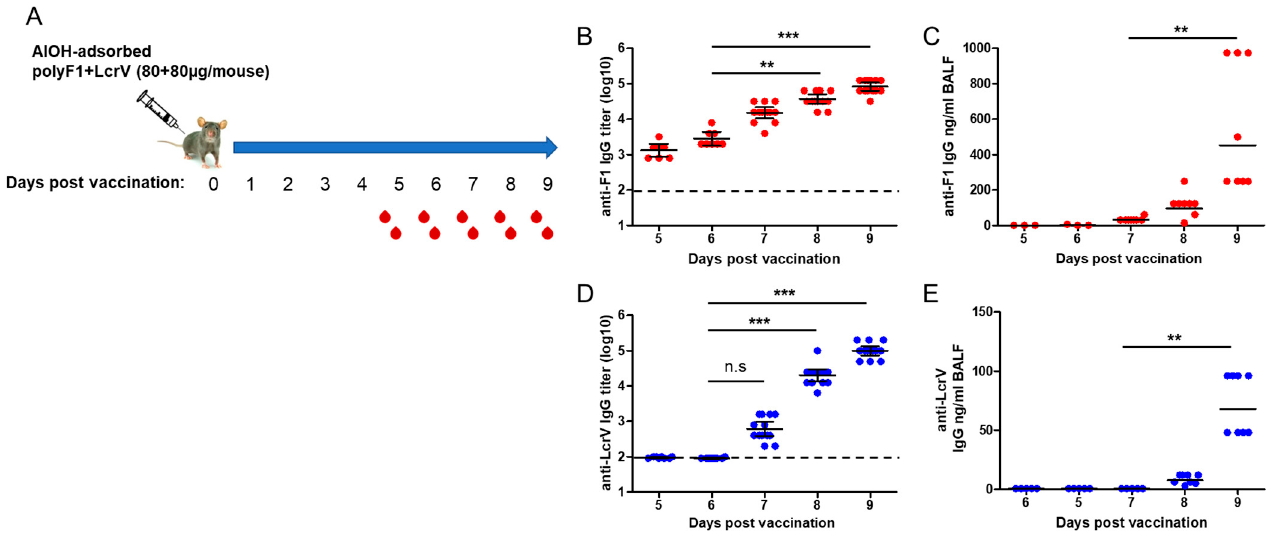
Figure 2. Kinetics of serological response following vaccination with polyF1 and LcrV. ( A ) Schematic description of the experiment designed to characterize the kinetics of the humoral response after a single vaccination with polyF1 and LcrV. Postvaccination days of terminal bleeding are marked below the time axis. Anti-F1 IgG endpoint titer and concentration determined in the ( B ) serum and ( C ) BALF (LOD = 0.78 ng/mL) of vaccinated mice. Anti-LcrV IgG endpoint titer and concentration measured in the ( D ) serum and ( E ) BALF (LOD = 0.15 ng/mL) of mice on the indicated days postvaccination. The horizontal dashed line marks the limit of detection in the serum. n.s.= nonsignificant, ** = p < 0.01, *** = p < 0.001.